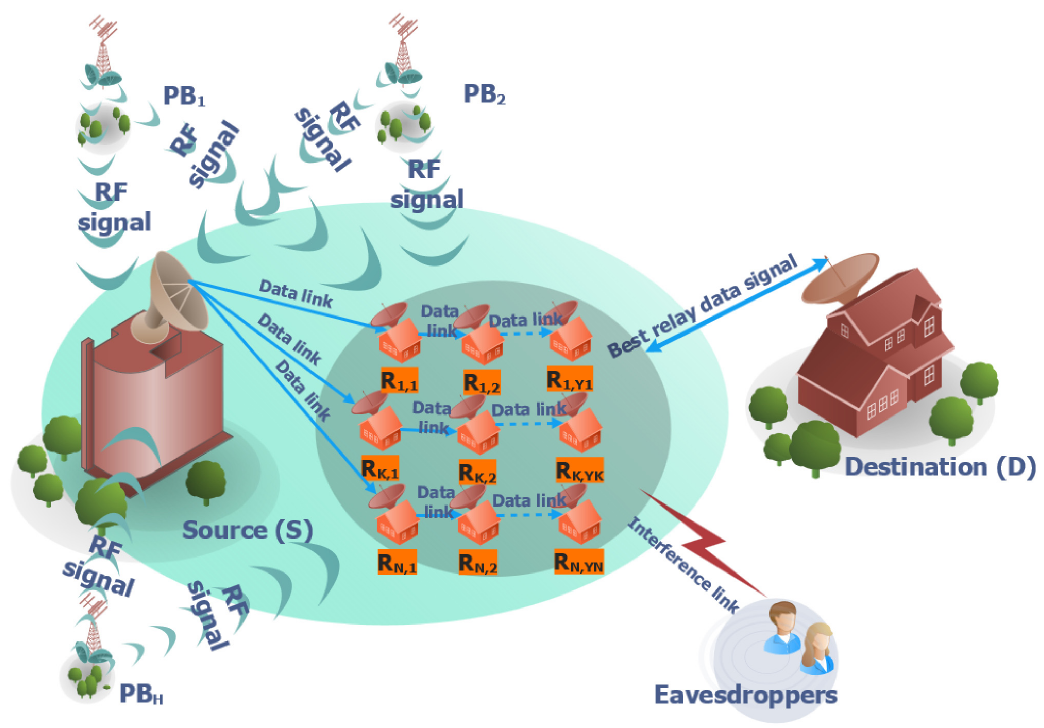
Fig 1. System model of PB-assisted relaying protocols with relay selection